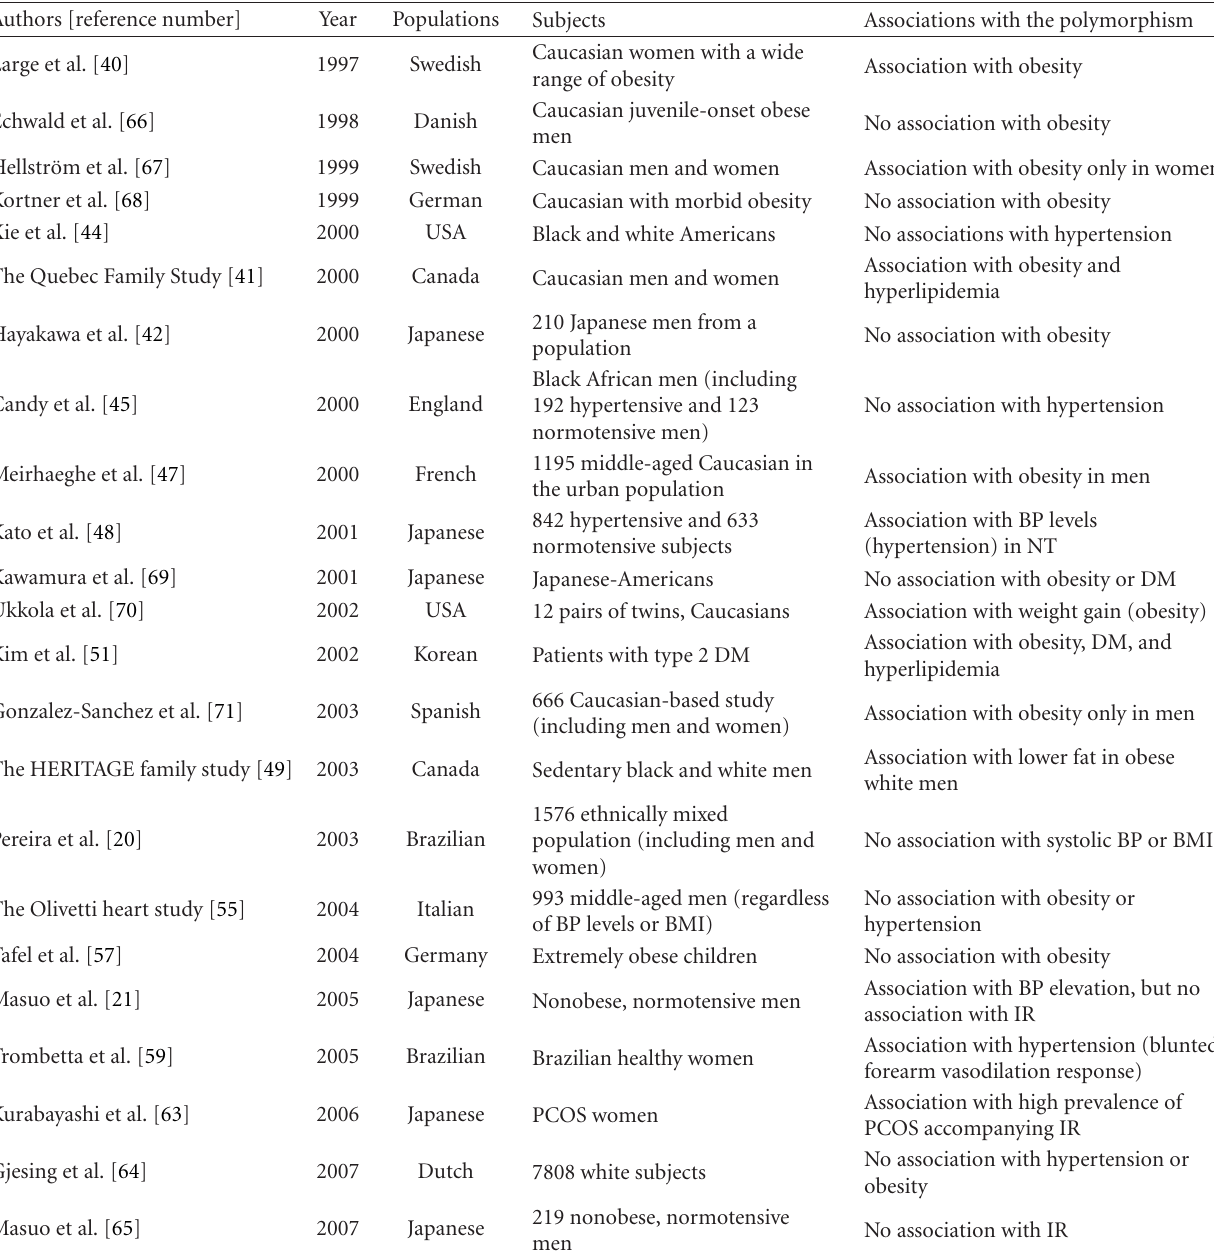
Table 3: Gln27Glu, β 2-adrenoceptor polymorphisms: association with hypertension, metabolic syndrome (type2 diabetes (DM)), and